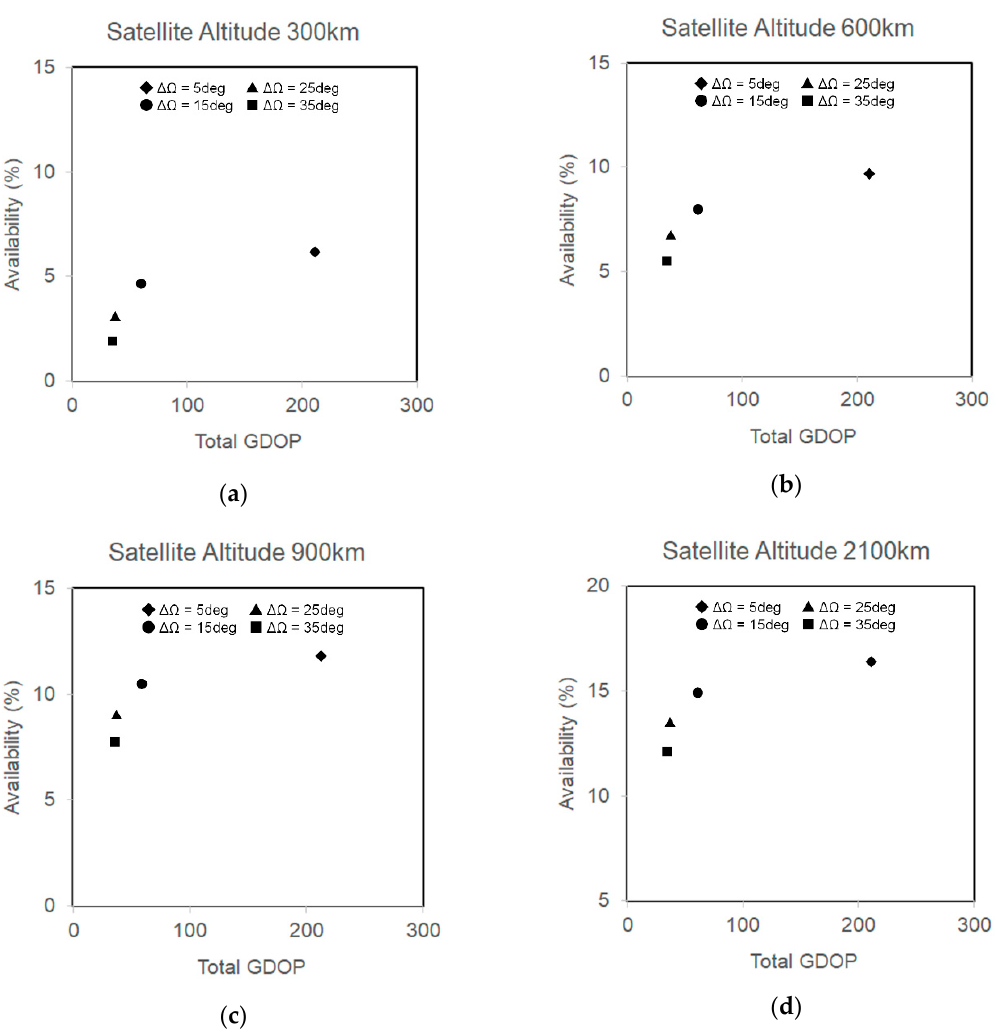
Figure 2. Availability and Total GDOP under different orbital conditions: circular orbits with four different satellite altitudes (300 km ( a ), 600 km ( b ), 900 km ( c ), 2100 km ( d )) and five different orbital phase differences ∆𝛺 between two satellites (5 deg, 15 deg, 25 deg, 35 deg). Rover/lander position were fixed to the south-pole ( − 90 deg, 90 deg) and satellite orbital inclination was fixed to 110 deg.